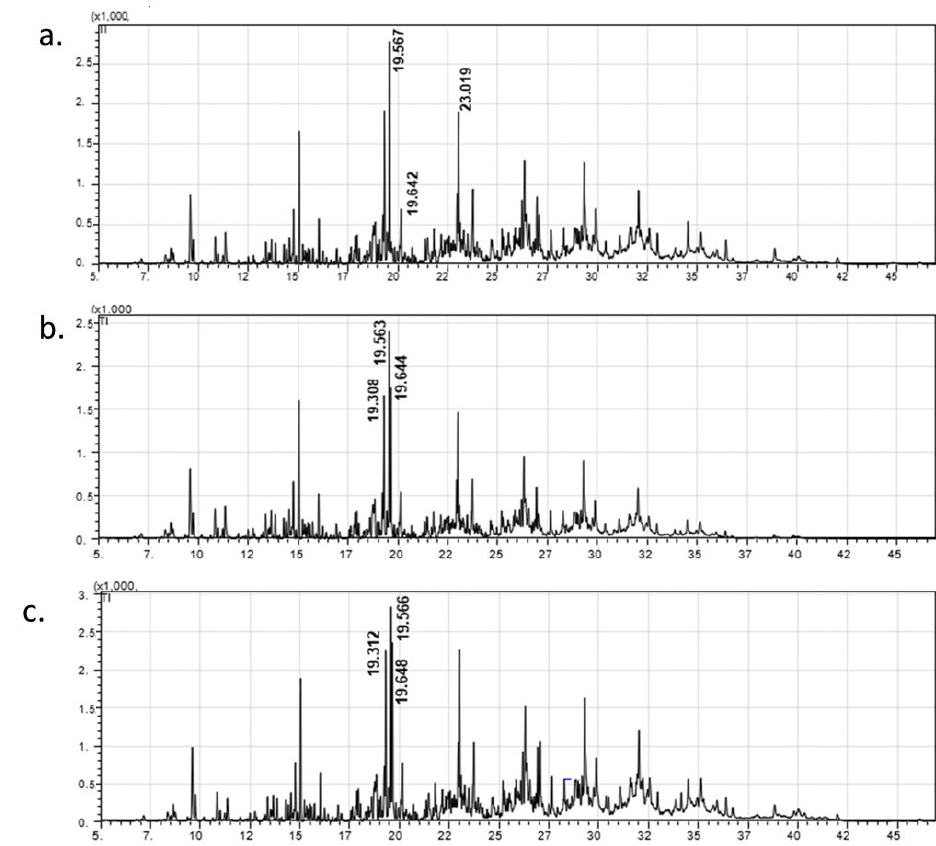
Figure 5. GC–MS of LDPE degradation products: ( a ) control, ( b ) APCK5, and ( c ) APCZ14.